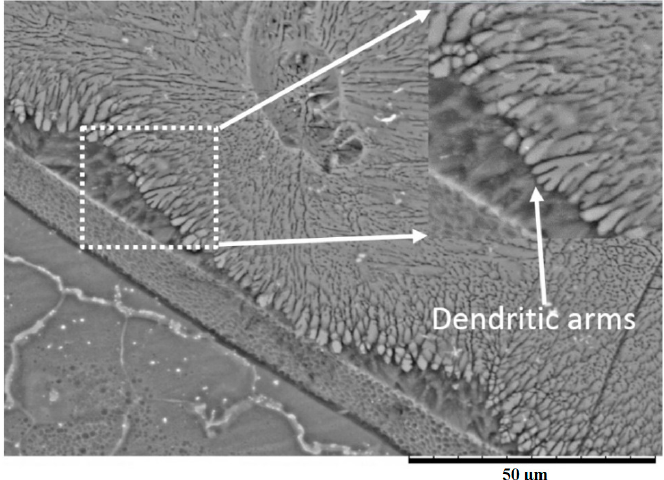
Figure 7. Microstructure of the weld pool close to the Mg interface.